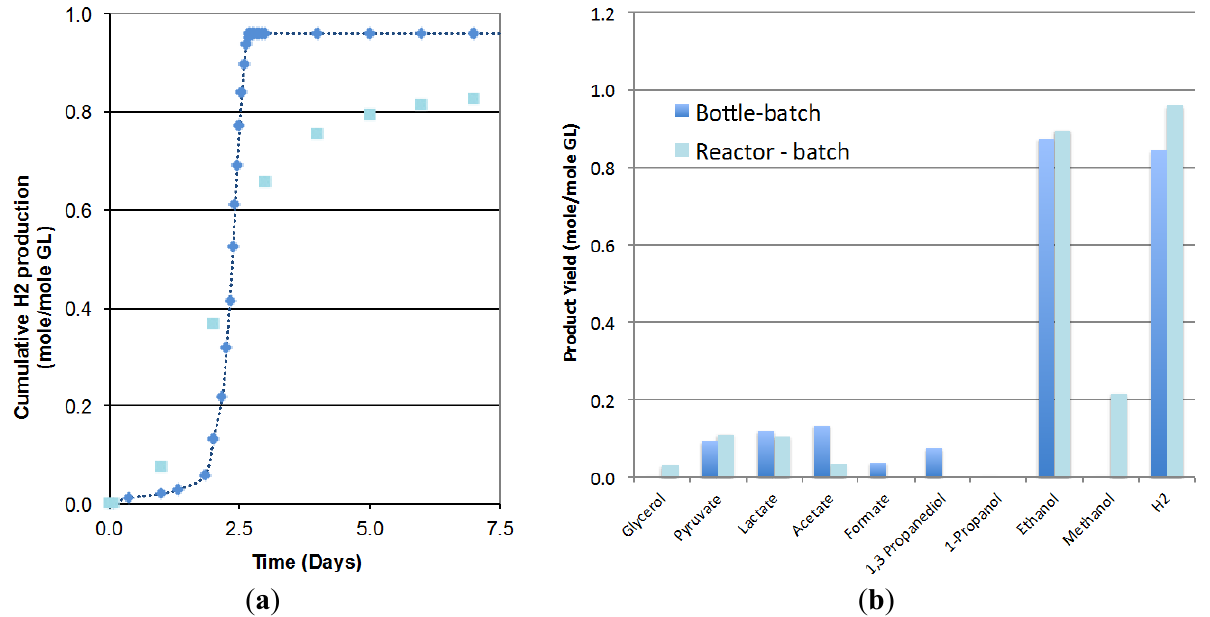
Figure 1. Comparison of ( a ) the hydrogen production; ( b ) the product formation, in the 3.6-L